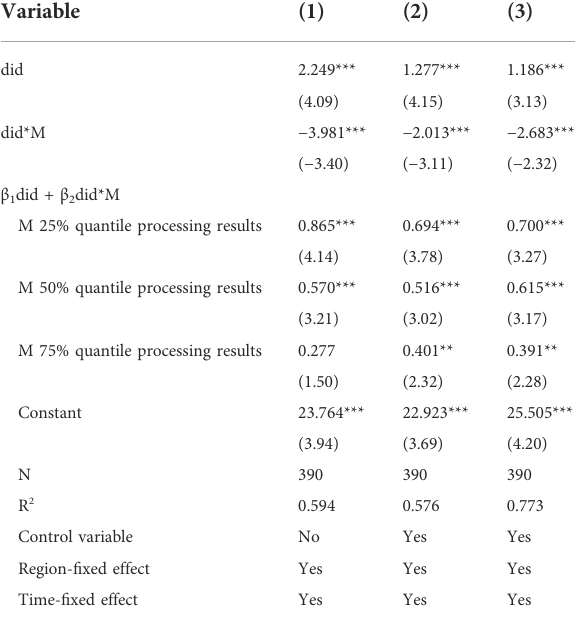
TABLE 7 Regression results of traditional mechanism analysis.